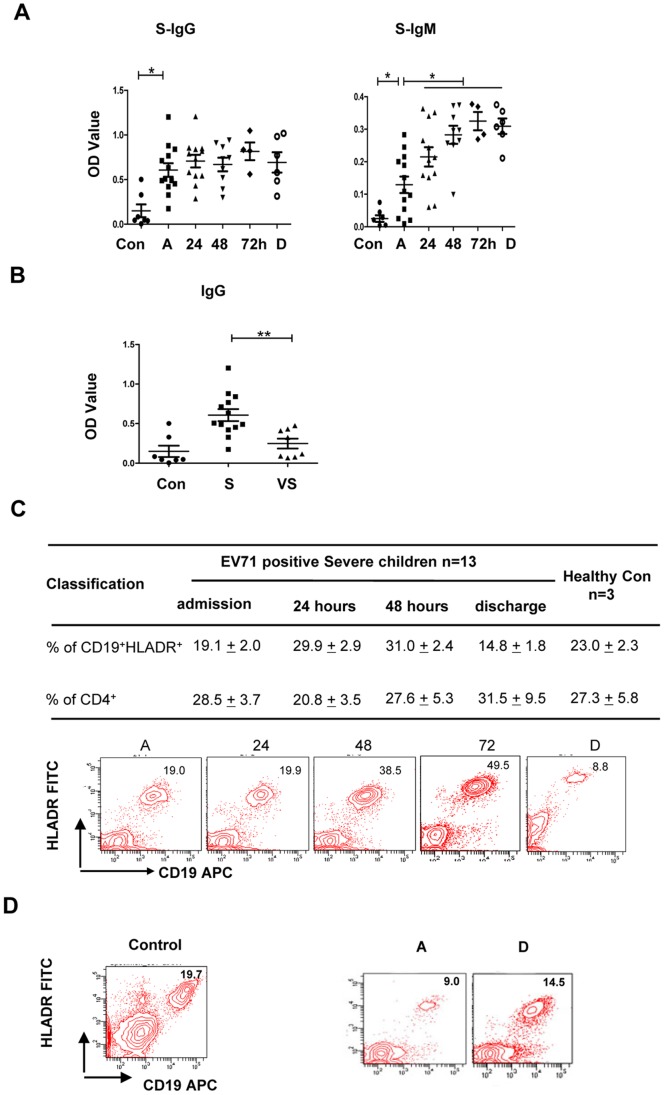
Production of EV71 VP-1–specific IgG and IgM antibodies in patients with increased frequency of CD19+HLA-DR+ cells.(A) IgG and IgM antibodies were rapidly increased and were markedly higher in plasma from severe patients (n = 13) compared with normal controls (n = 7). The differences between two time points of every individuals were determined by Wilcoxon’s Sign Rank Test. *P<0.05. (B) Very severe patients with acute respiratory failure (n = 8) have lower IgG secretion as compared to patients with uncomplicated neurological manifestations (n = 13), which were both examined before treatment. The unpaired Student’s t-test and non-parametric ANOVA test were used to compare variables between the indicated 2 groups. **P<0.01. (C) Frequency of CD19+HLA-DR+ lymphocytes in peripheral blood of severe patients (n = 13) and healthy controls (n = 3). Data are expressed as the percentage of the examined cell subset within gated lymphocytes. The lower panel showing representative data from a severe patient indicated that CD19+HLADR+ frequency increased during the course of hospitalization. (D) Representative FACS data examining CD19+ cells from a healthy control and a mild patient with no neurological manifestations.